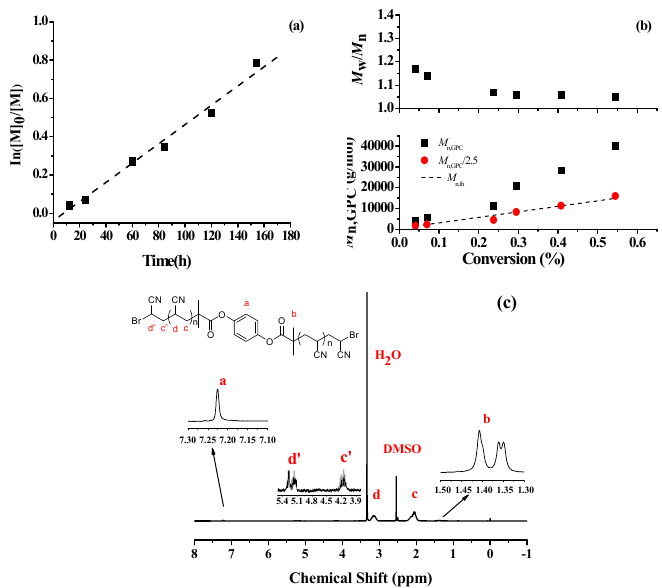
Figure 1. ln([M] 0 /[M]) as a function of time ( a ) and number-average molecular weight and molecular weight distribution ( M w / M n ) versus monomer conversion ( b ) for the initiators for a continuous activator regeneration atom transfer radical polymerization (ICAR ATRP) of acrylonitrile (AN) under ambient pressure; ( c ) The 1 H NMR spectrum of polyacrylonitrile (PAN) ( M n,GPC = 28,400 g·mol − 1 , M w / M n = 1.06, conversion = 40.8%) with dimethylsulfoxide (DMSO) as the solvent and tetramethylsilane (TMS) as the internal standard. Polymerization conditions: [AN] 0 :[BMPB 2 ] 0 :[CuCl 2 ·2H 2 O] 0 :[TPMA] 0 :[AIBN] 0 = 500:1:0.01:0.1:0.2, V AN = 1.5 mL, V DMSO = 3.0 mL, T = 30 °C under ambient pressure.